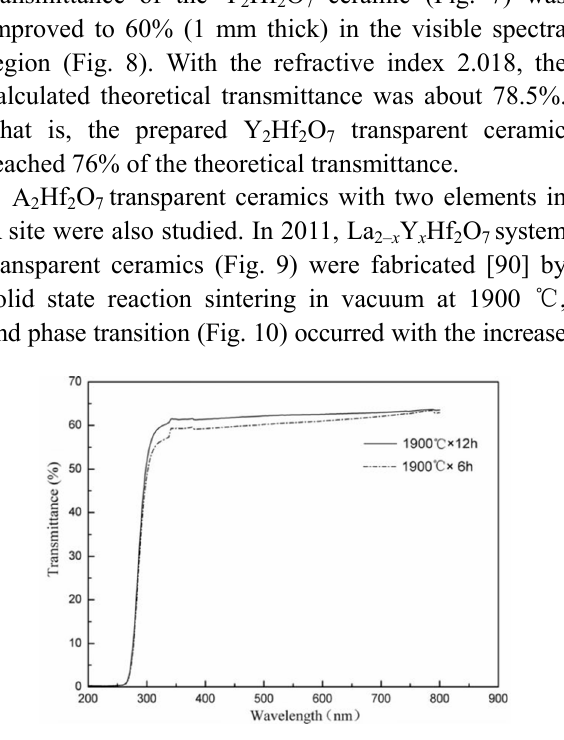
Fig. 8 Transmittance of the mirror-polished Y 2 Hf 2 O 7 transparent ceramics (1 mm thick). Reproduced with permission from Ref. [87], © Elsevier B.V. 2012.